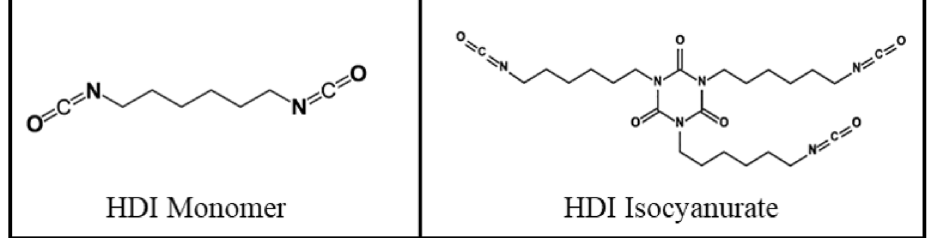
Figure 1. Chemical structures of HDI monomer and one of its trimers, HDI